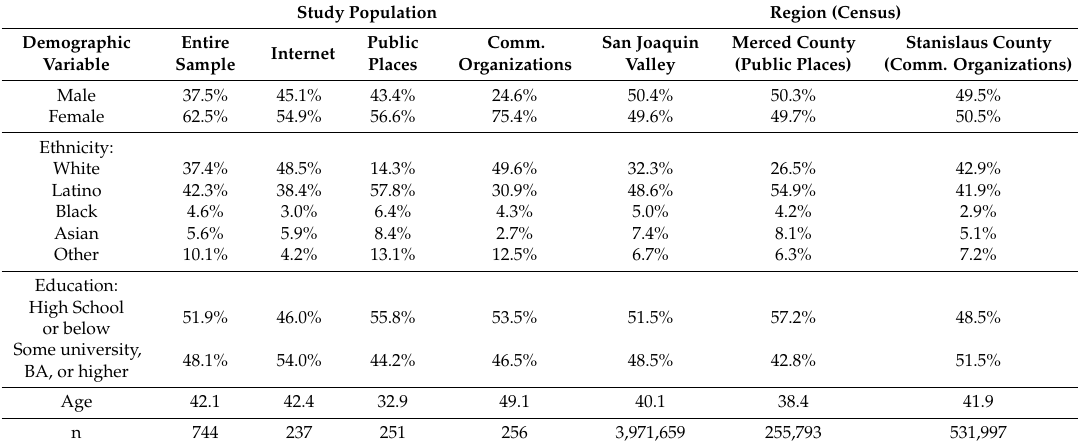
Table 1. Demographics of study